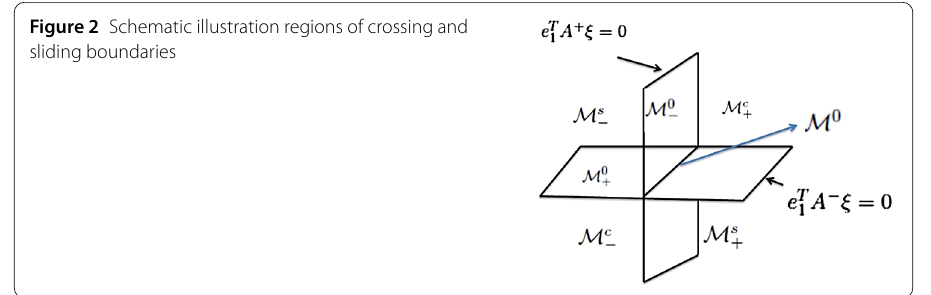
Figure 2 Schematic illustration regions of crossing and sliding